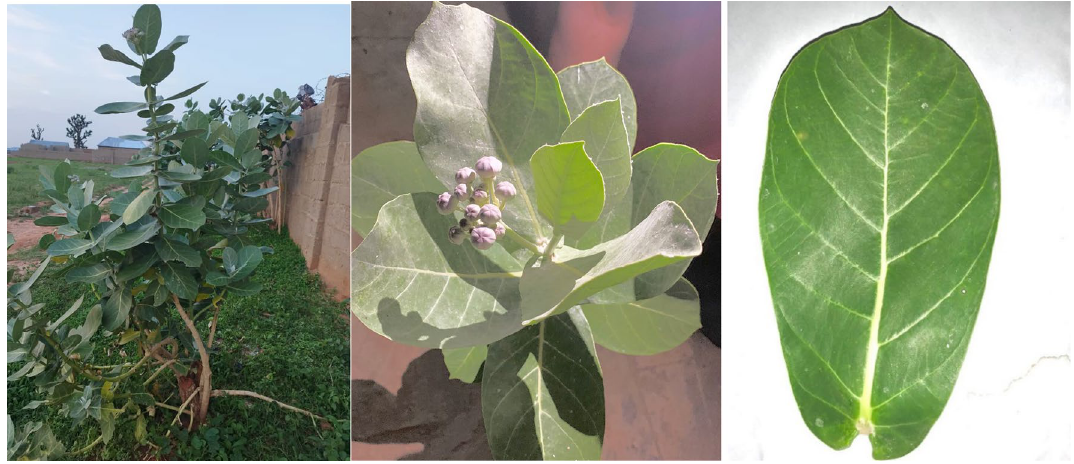
Fig. 1 Pictures of Calotropis procera collected from